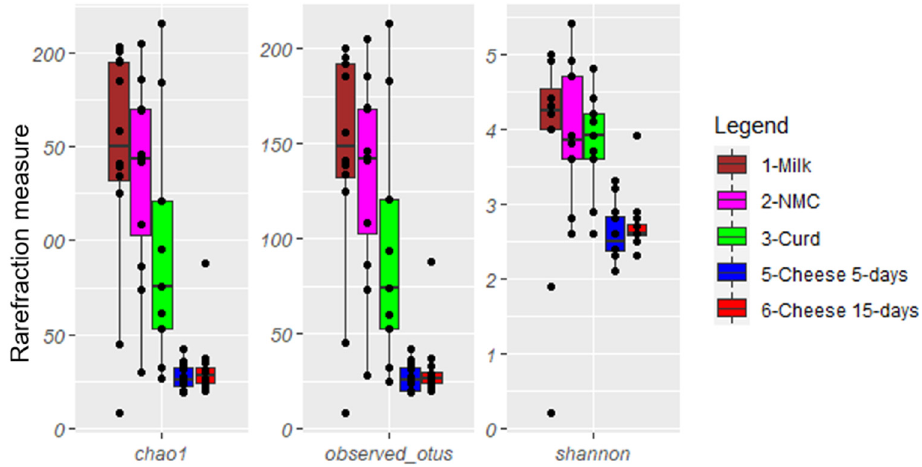
Figure 2. Boxplots describing α -diversity measures of milk, natural milk cultures (NMC), curd, 5- and 15-day ripened cheese.